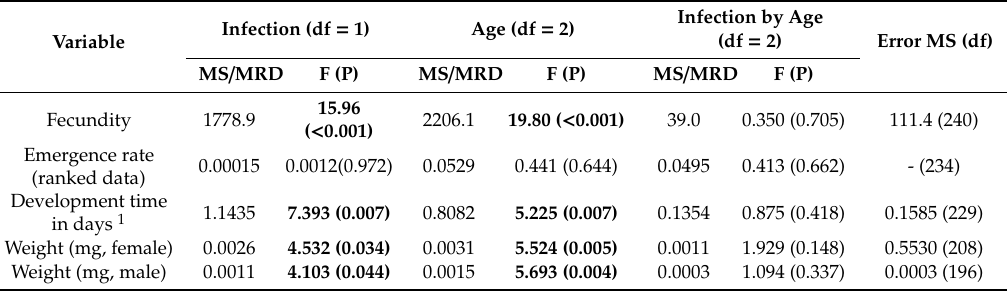
Figure 2. Violin plots for ( a ) fecundity (number of eggs), ( b ) development time, ( c ) female weight, and ( d ) male weight of w Au-infected and uninfected lines reared on laboratory medium with parents transferred across three days to new medium (5-, 6-, and 7-day-old parents). Medians are indicated by central points, and the interquartile range by the solid bar, while the dotted line indicates the 95% confidence interval. Table 3. ANOVAs (MS = mean square or MRD = mean square for emergence based on ranked data, F ratio, probability) for fecundity and emergence rate, as well as an ANCOVA performed on preimaginal development when flies were reared on laboratory medium and transferred daily for three days to produce di ff erent parental ages. Significant results ( p < 0.05) are indicated in bold. The ANCOVA on development time included the emergence number as a